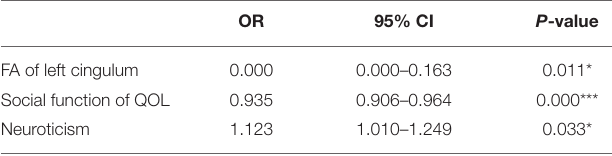
TABLE 5 | Factors correlated to felt stigma by logistic regression